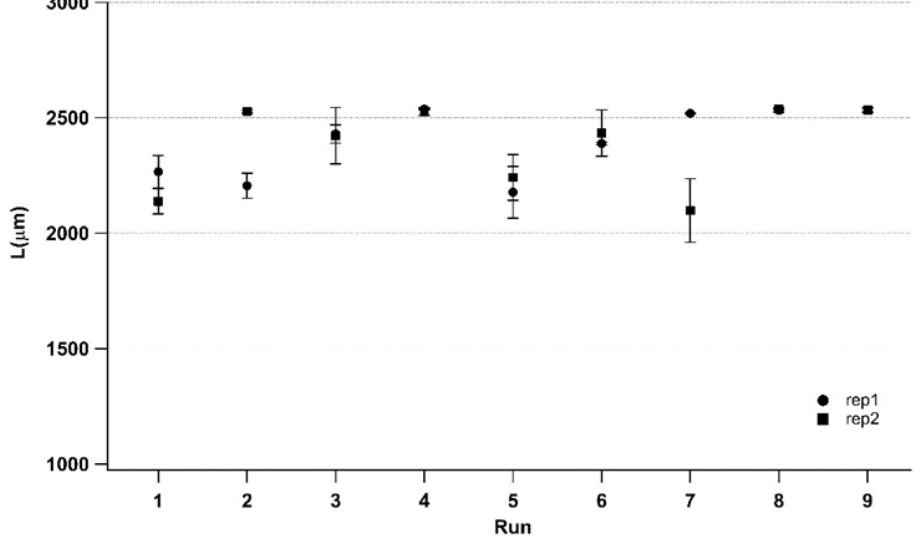
Figure 9. Component lengths and standard deviation of three samples for each treatment of the two replications.